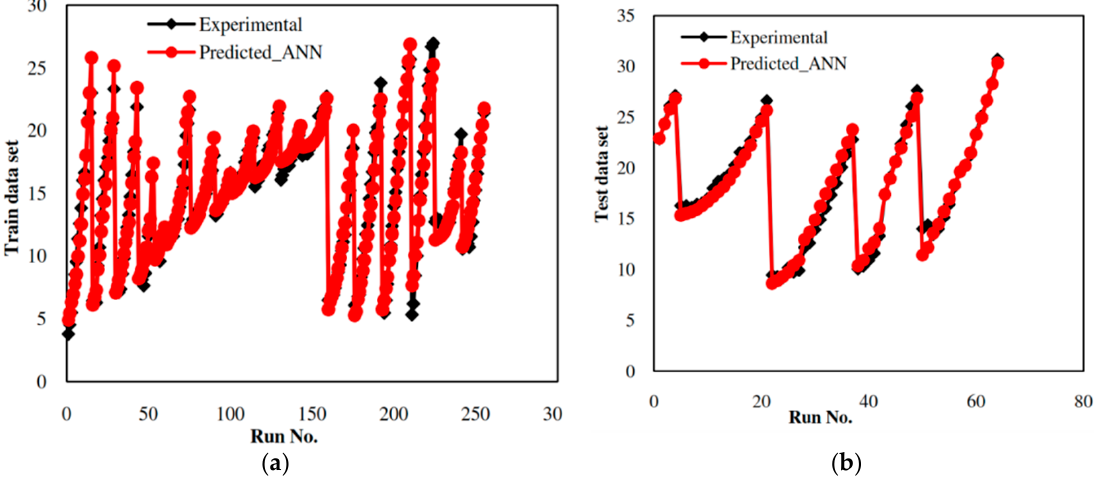
Figure 2. ( a ) Training course curve for the heat transfer coefficient. ( b ) Test course curve for the heat transfer coefficient.